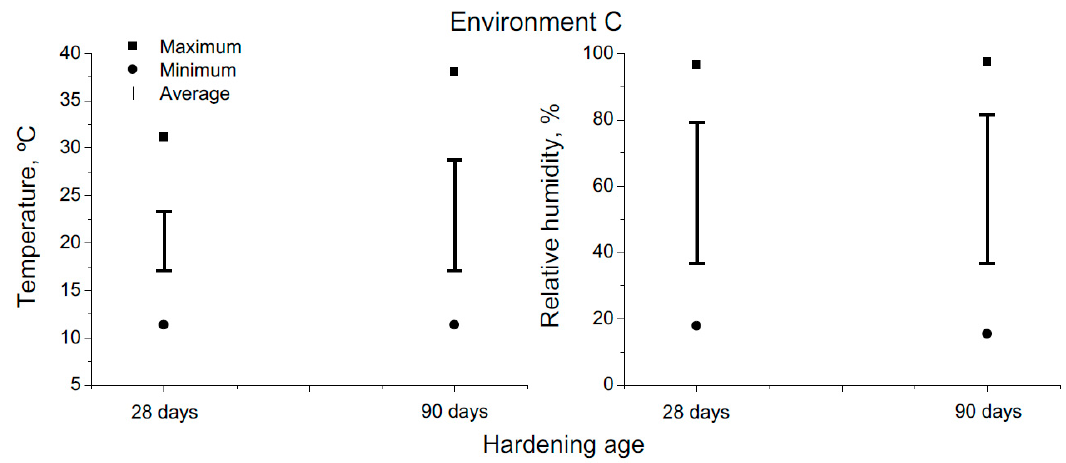
Figure 5. Absolute maximum, absolute minimum and interval of average temperature and relative humidity at which the samples were exposed to environment C for 28 days- and 90 days-period.